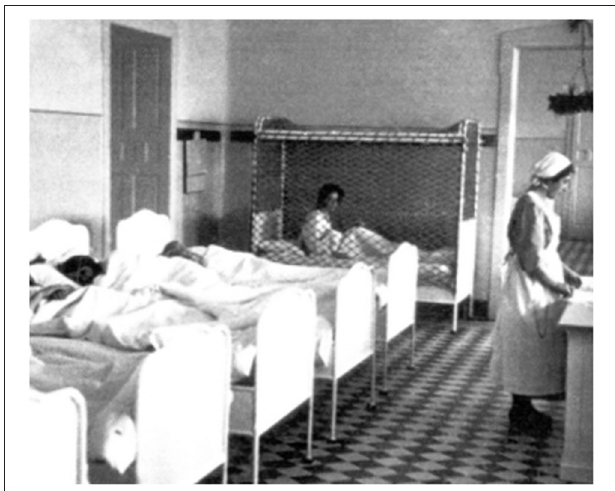
FIGURE 3 | Photo 2. The photo’s caption was “Hospital ward of a sanatorium, approx. 1935.” Source reference: DÖW, Foto-Signatur 7908.